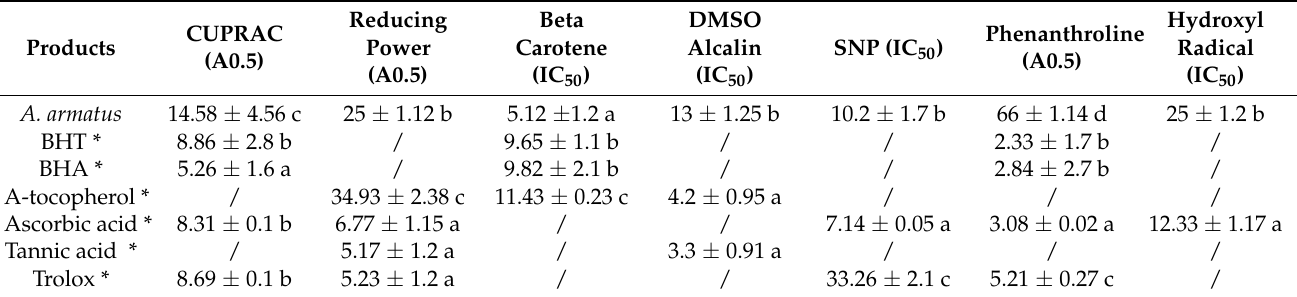
Table 2. Antioxidant activity the ethanolic fraction of A. armatus